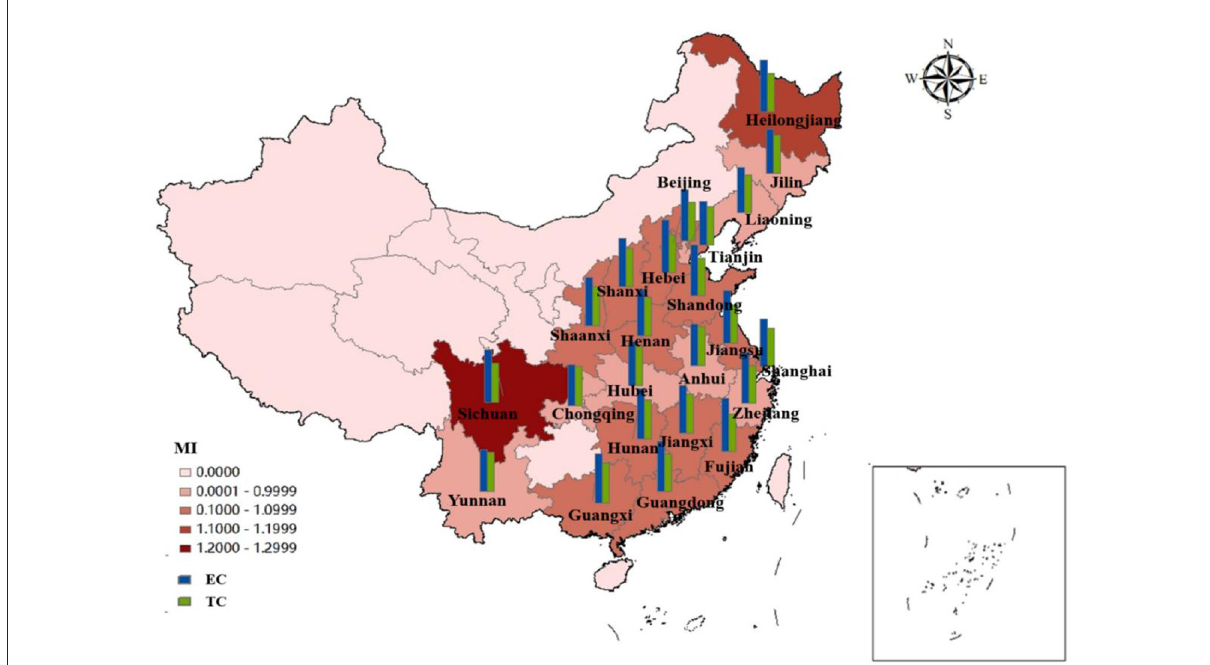
FIGURE5 Average efficiency and its decomposition index of ERDS in 23 Chinese provinces from 2010 to